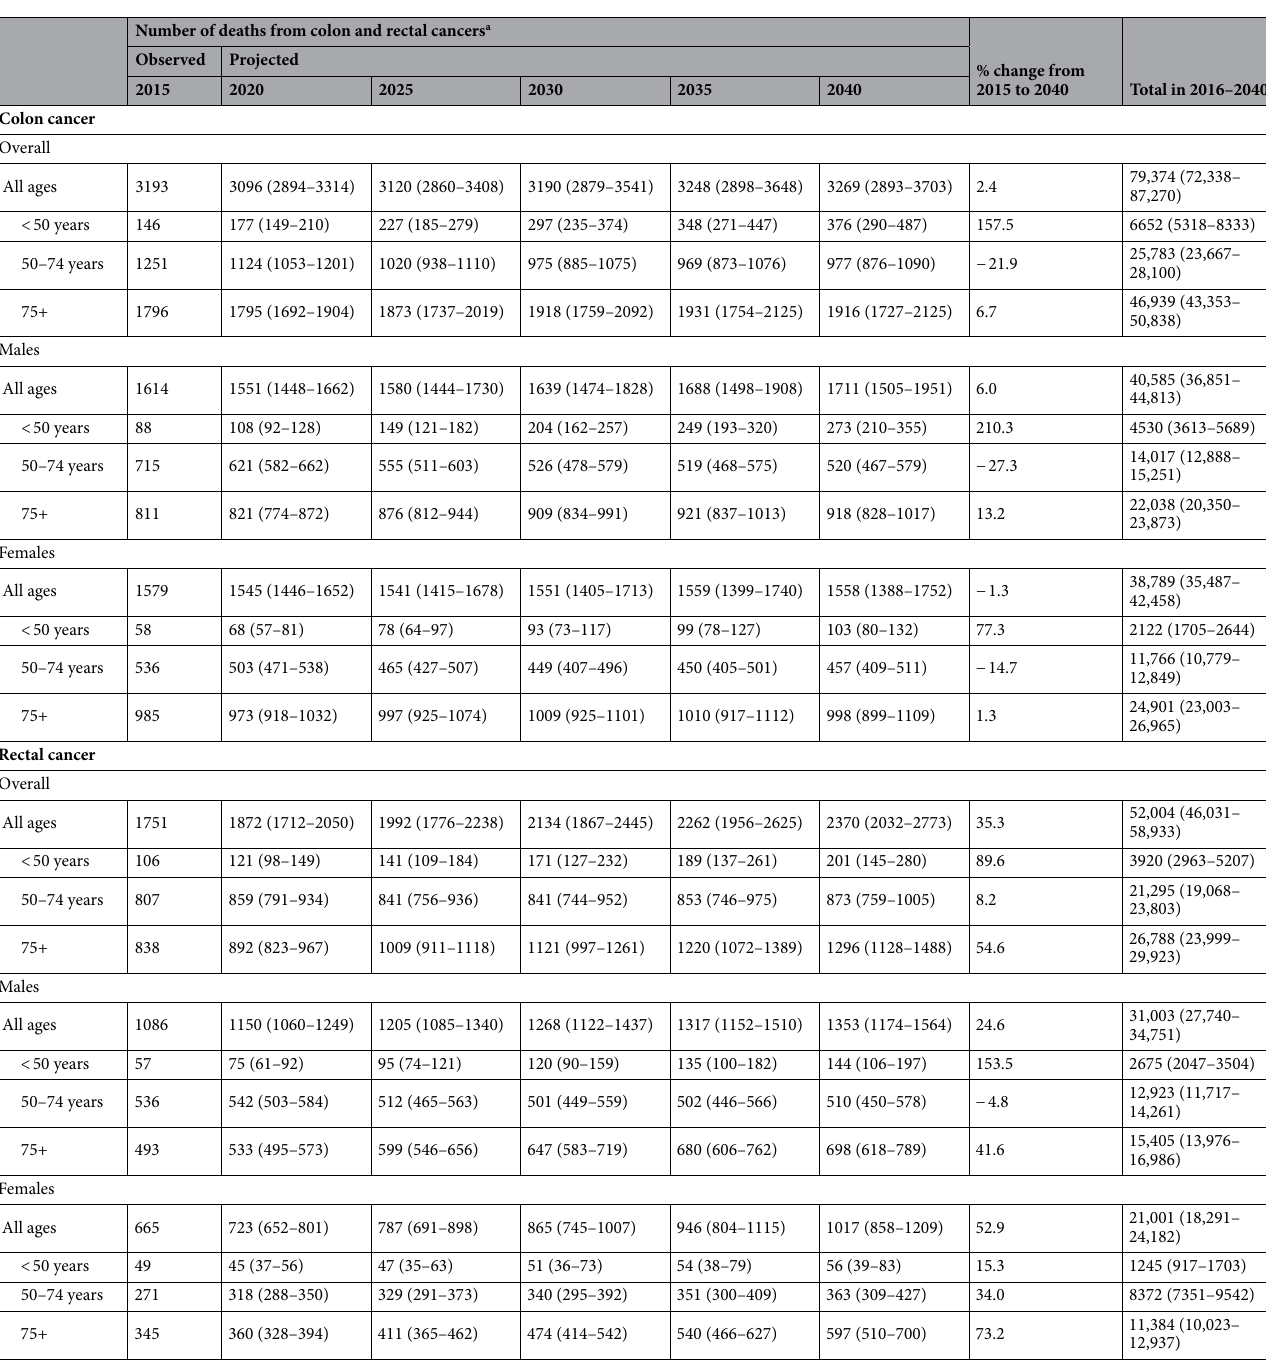
Table 2. Observed and projected numbers of deaths from colon and rectal cancers to 2040 in Australia. a The numbers of deaths were estimated by applying the NSW sex and age-specific mortality rates to the whole Australian